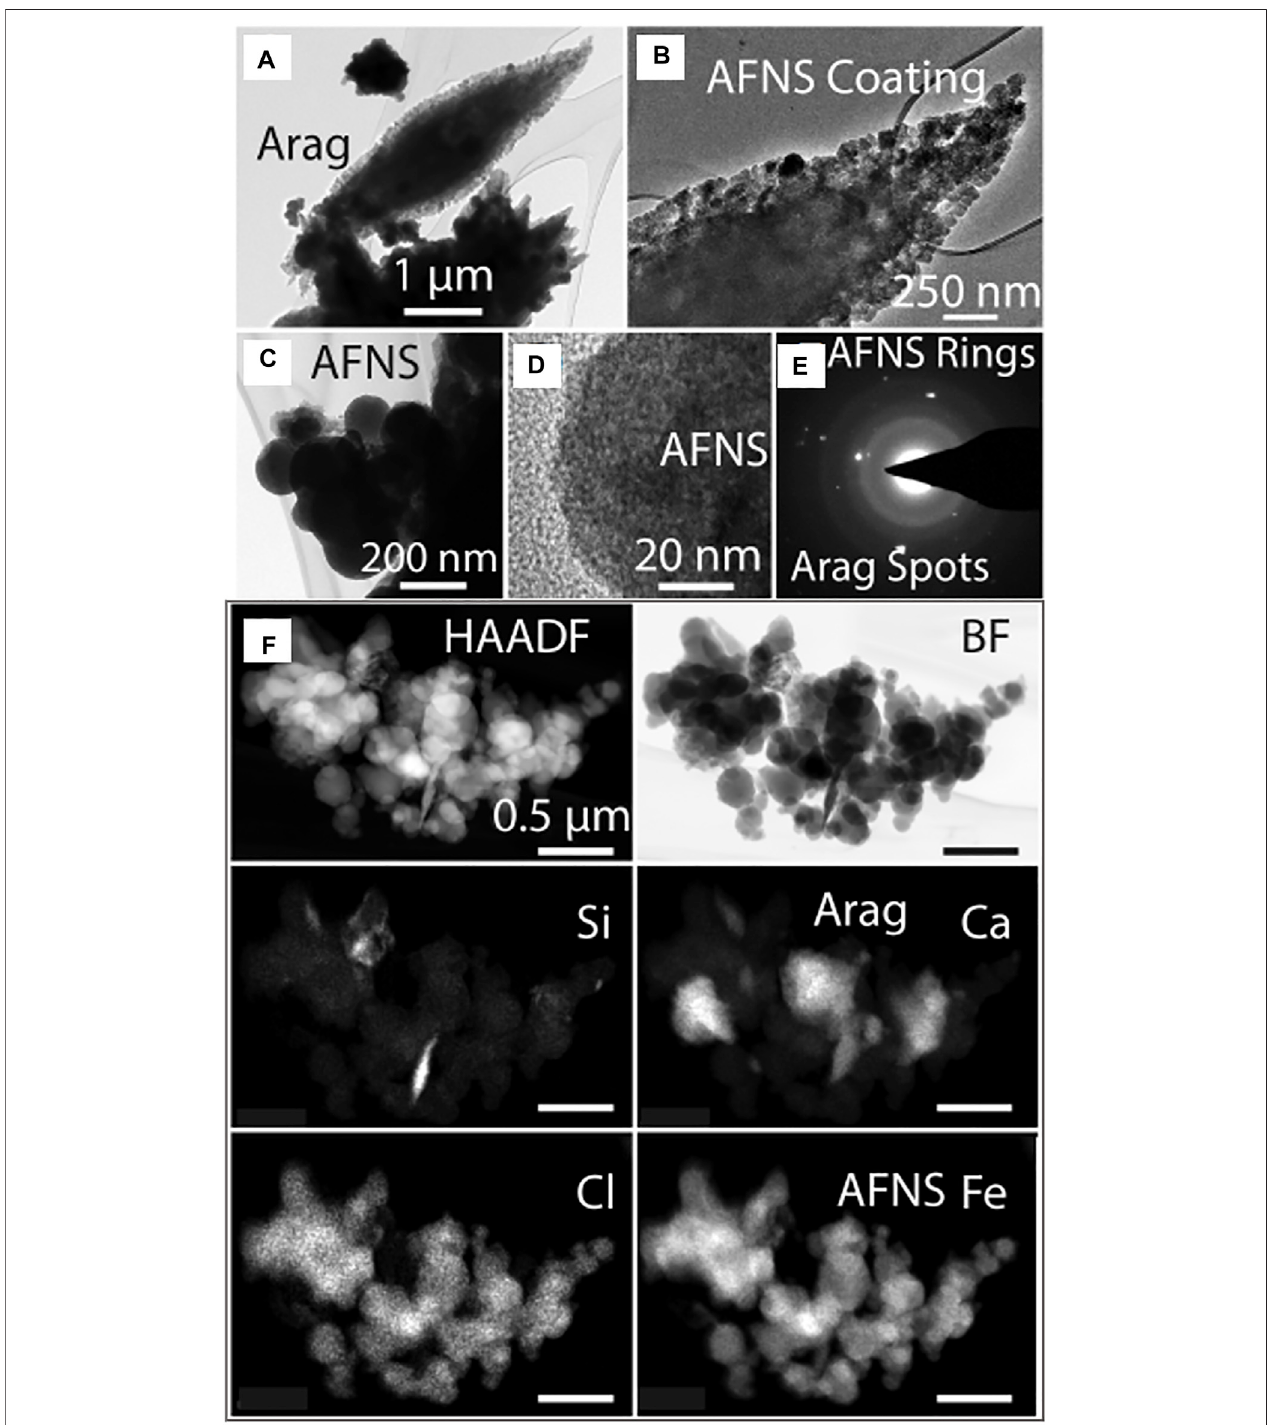
FIGURE 10 | TEM Results for ES126. (A) Aragonite crystals in the “ seed ” and “ star ” habit. ( See Supplementary Figures S28, S30 for more “ star ” aggregates). Darkparticleattopisacrosssectionofthe “ seed ” habit( see alsoSupimagesforES128).The “ star ” habitalsoisdecoratedbyAFSN. (B) CoatingofAFNSandaragonite nanoparticles on the “ seeds. ” (C) Small collection of AFNS attached to a larger aragonite crystal. (D) HRTEM image of a single AFNS particle showing its amorphous nature (no lattice fringes). (E) SAED pattern of collection of AFNS. The AFNS yields broad rings typical of amorphous materials. Individual spots were indexed as being from adjacent aragonite. (F) HAADF and bright- fi eld scanning (BF) TEM images of a cluster of AFNS and aragonite particles. Images below are X-ray maps for K α lines of Si, Cl, Ca and Fe. The AFNS particles have signi fi cant Cl, Si and Mg (not shown). The bright area in the Si map belongs to a layered silicate (K-rich).